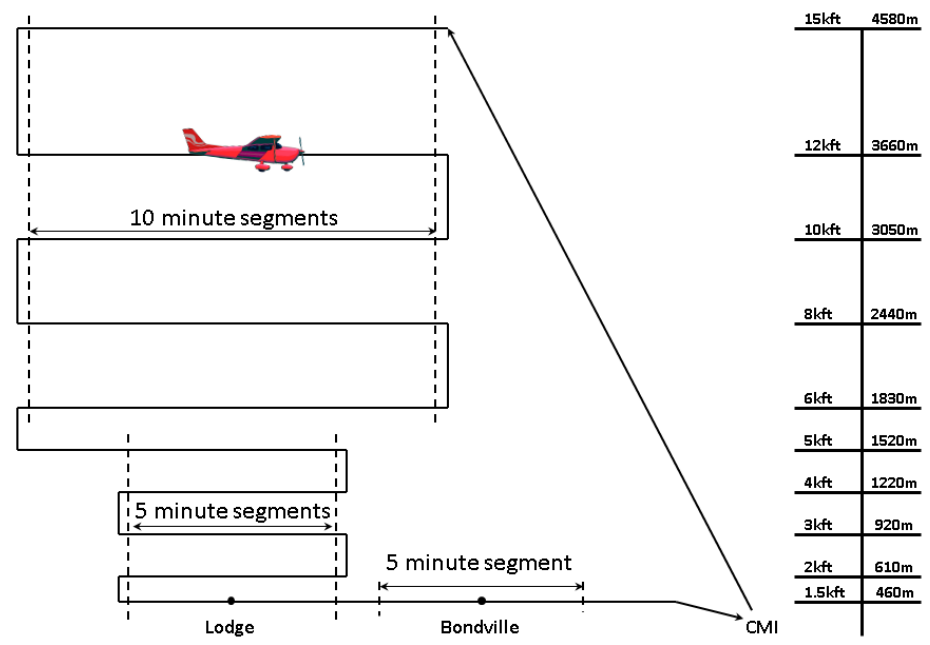
Fig. 4. A typical aircraft vertical profile over the Lodge profile site. Altitudes are relative to mean sea level. A 5-min low pass was typically conducted over the Bondville surface monitoring station on the way back to the